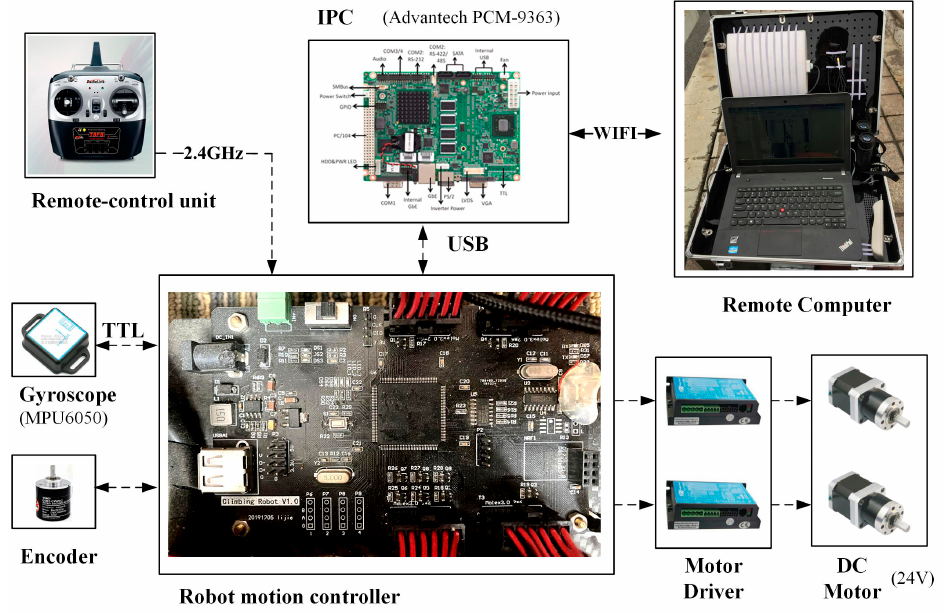
Figure 13. Control system of the pipeline-climbing robot.